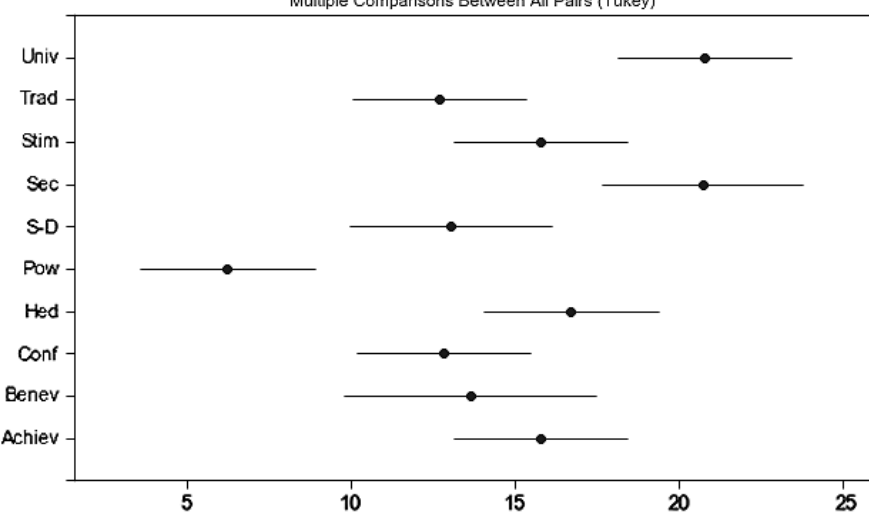
Figure 6. Difference between subdimensions of SVS in understanding consumer rating.